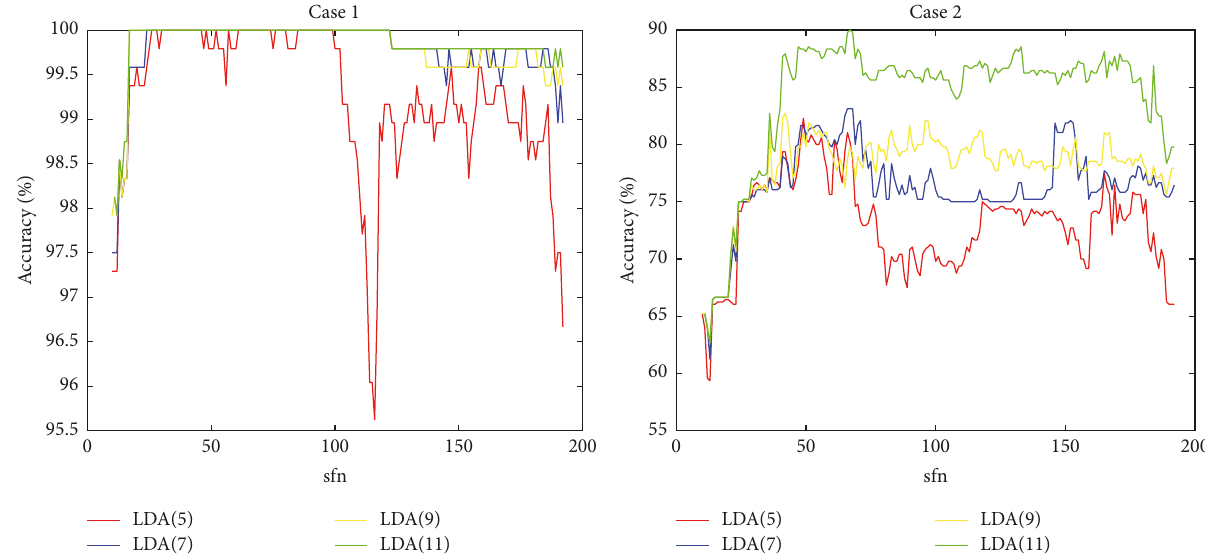
Figure 17: The diagnosis results obtained by OFS-FSASD-LDA-SVM using WPT with different dimension sizes for LDA. The LDA (5) represents that the number of dimension sizes is 5.